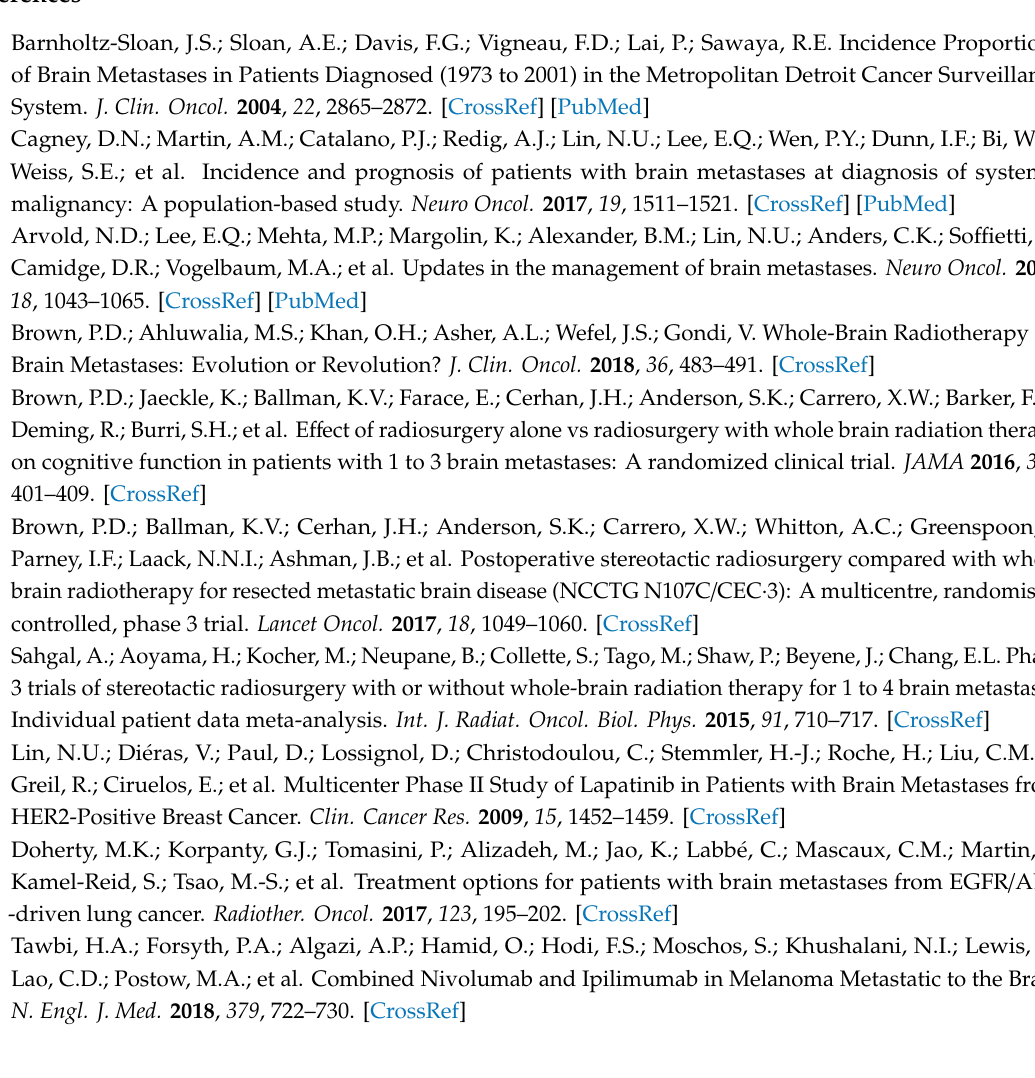
Figure S1: Kaplan Meier survival plot showing a comparison of overall survival for patients diagnosed with brain metastasis during 2003–2010 and 2011–2014. Table S1: Systemic therapies used for long-term survivors. Table S2: Correlation of di ff erent factors with intracranial disease-free survival and overall survival for the long-term